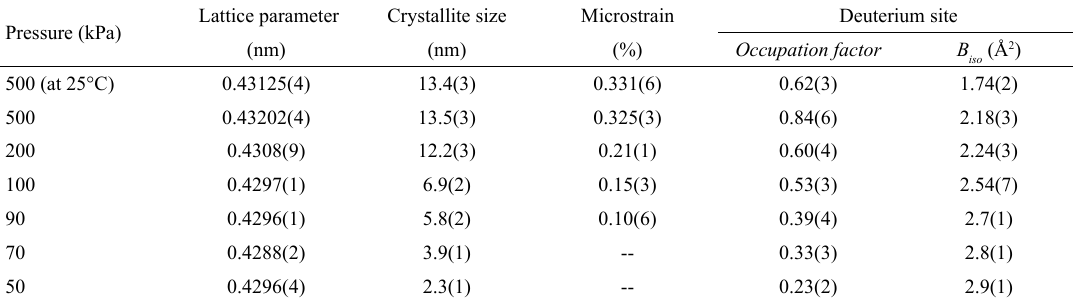
Table 3: Crystallographic parameters of the FCC phase as evaluated from Rietveld refinement during dehydrogenation of 52Ti-12V- 36Cr+4%wt. Zr Ni alloy. All measurements are at 200°C unles stated otherwise. Numbers in parenthesis are one standard deviation of 7 10 the last significant digit.